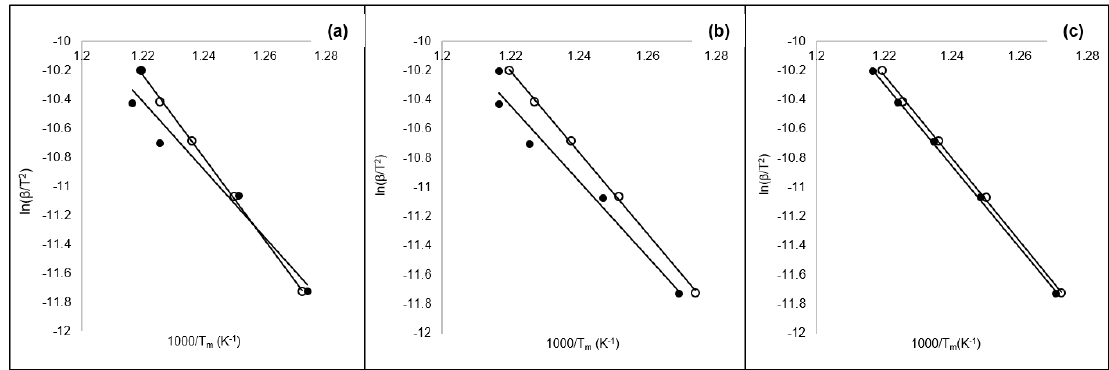
Figure 4. Determination of apparent activation energy ( E a ) using Kissinger’s isoconversion method for unexposed ( ○ ) and exposed ( ) samples of the ( a ) 50/50, ( b ) 25/75, and ( c ) 0/100 blends.